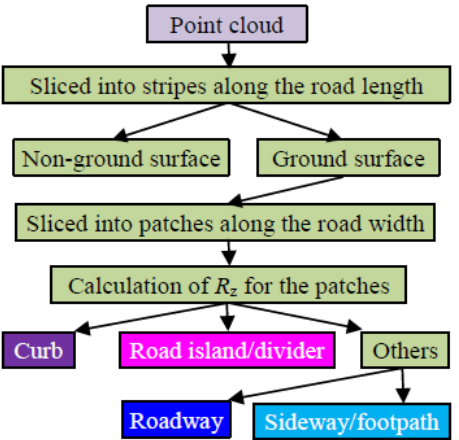
Figure 1. Workflow of the proposed road surface extraction method.